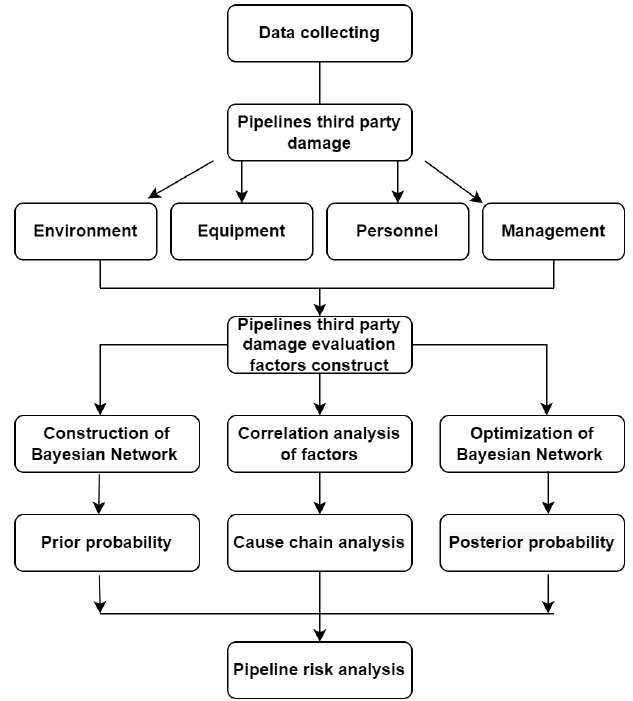
Figure 1. Pipeline third-party damage risk assessment